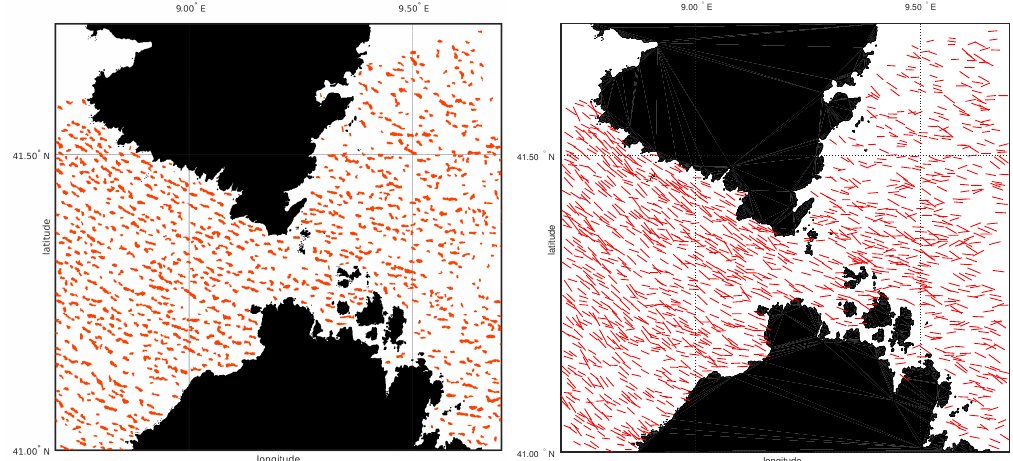
Figure 4. Results from the 2D-CWT analysis of the image shown in the right panel of Figure 3. Left panel : ˜ R im ( x , y ) showing the backscatter cells related to the wind. Right panel : the aliased wind direction obtained from the orientation of the major axis of the backscatter cells showed in the left